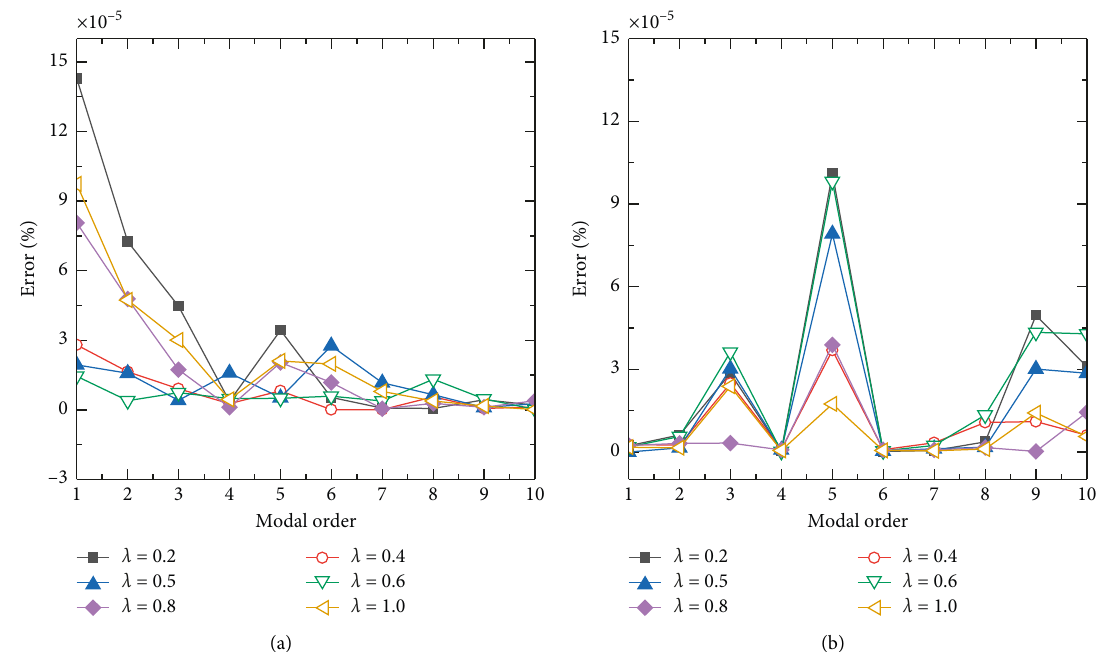
Figure 4: Percentage error of the dimensionless frequencies for the ultraspherical polynomial parameters λ . (a) CCCC. (b)